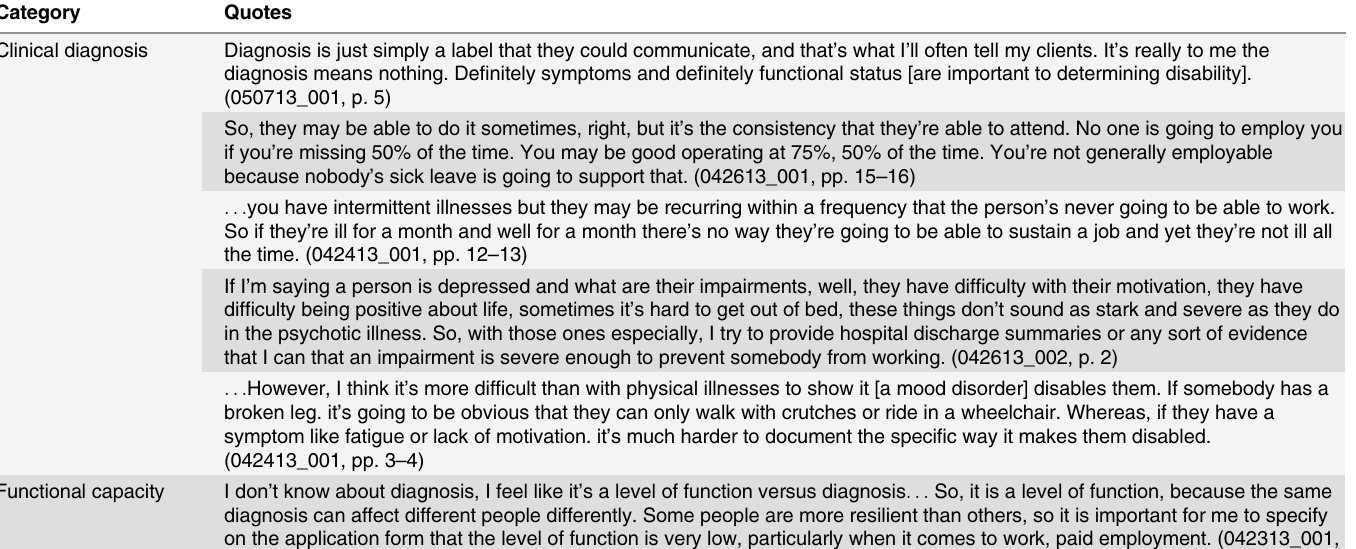
Table 2. Theme of Complexity of Factors Contributing to Work Disability Categories and Quotes.